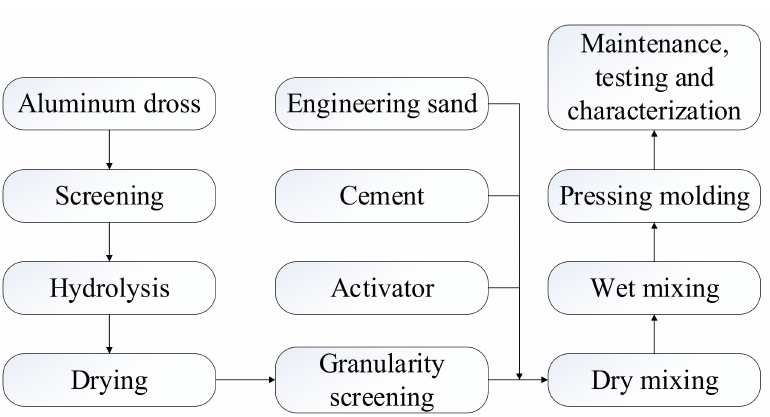
Figure 3. Process flow of aluminum dross to prepare non-fired bricks.